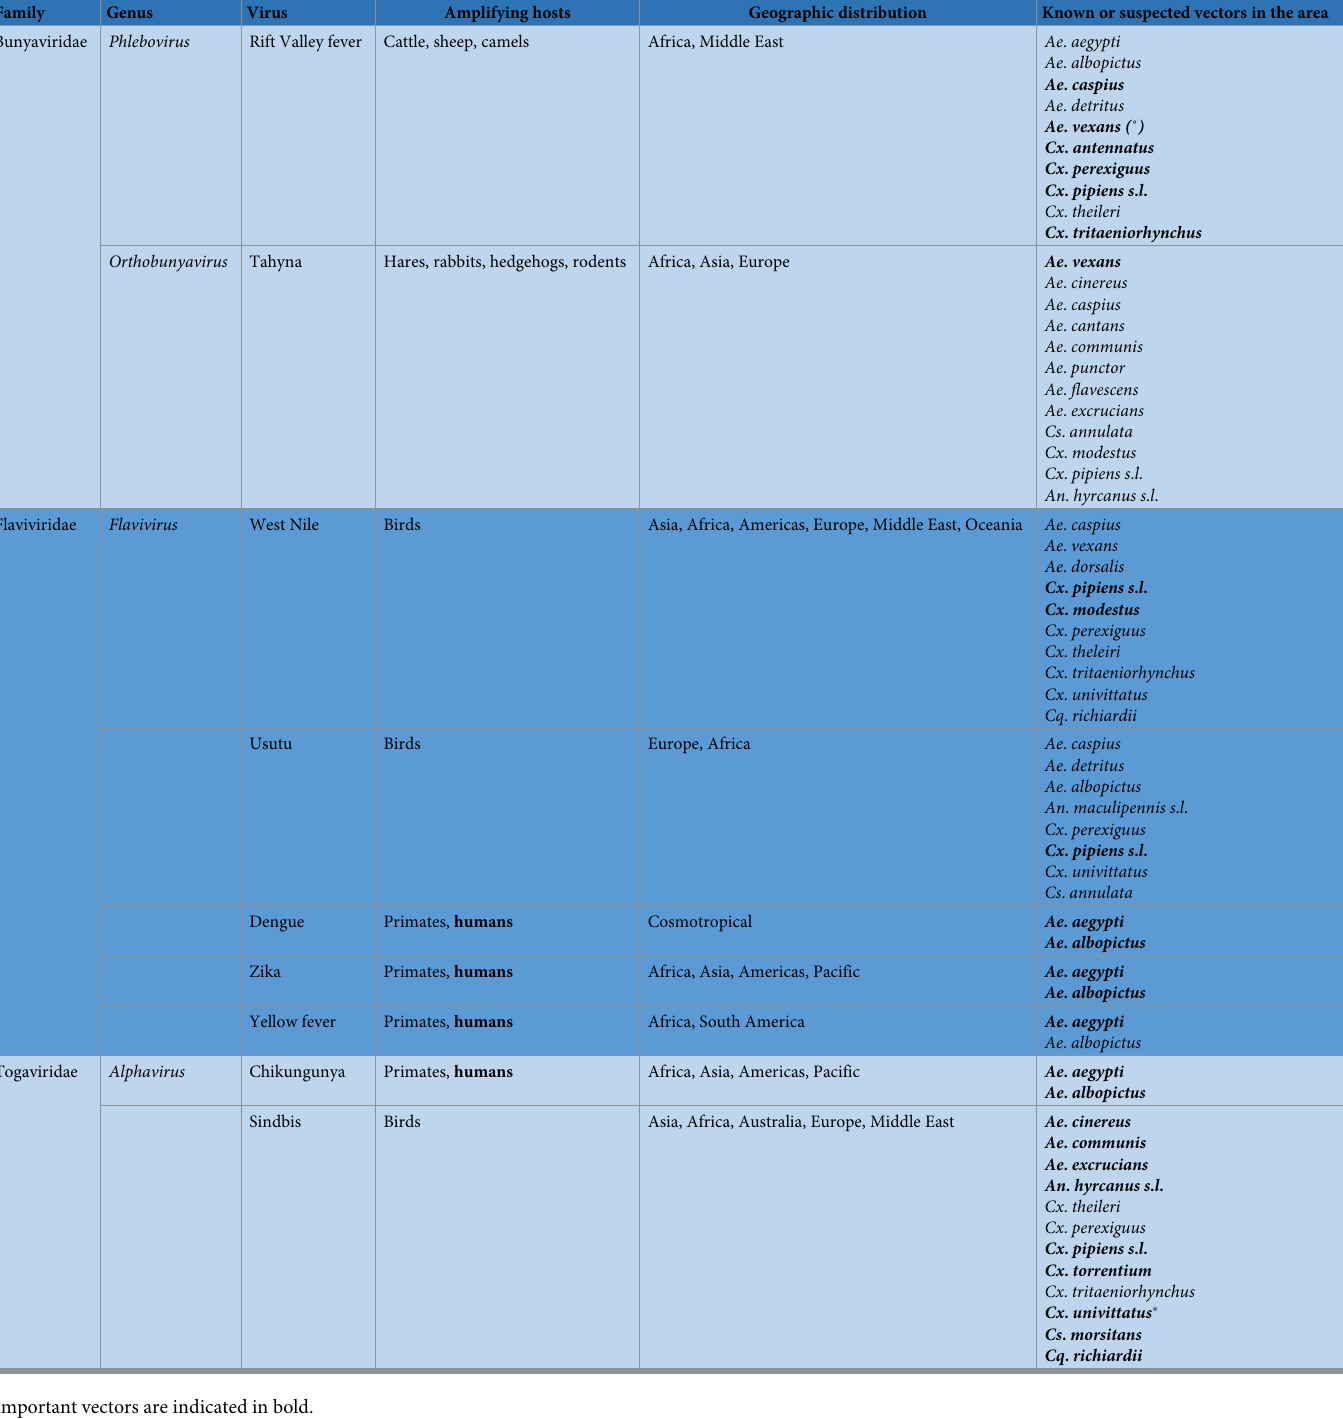
Table 1. Literature-based inventory of known and suspected arbovirus vectors in the Mediterranean area